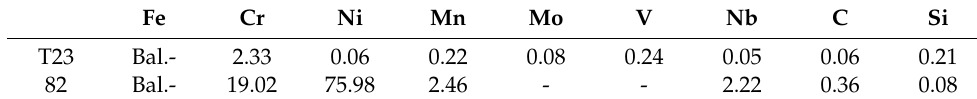
Table 1. Chemical compositions of T23 steel base metal and 82 weld metal (wt.%).